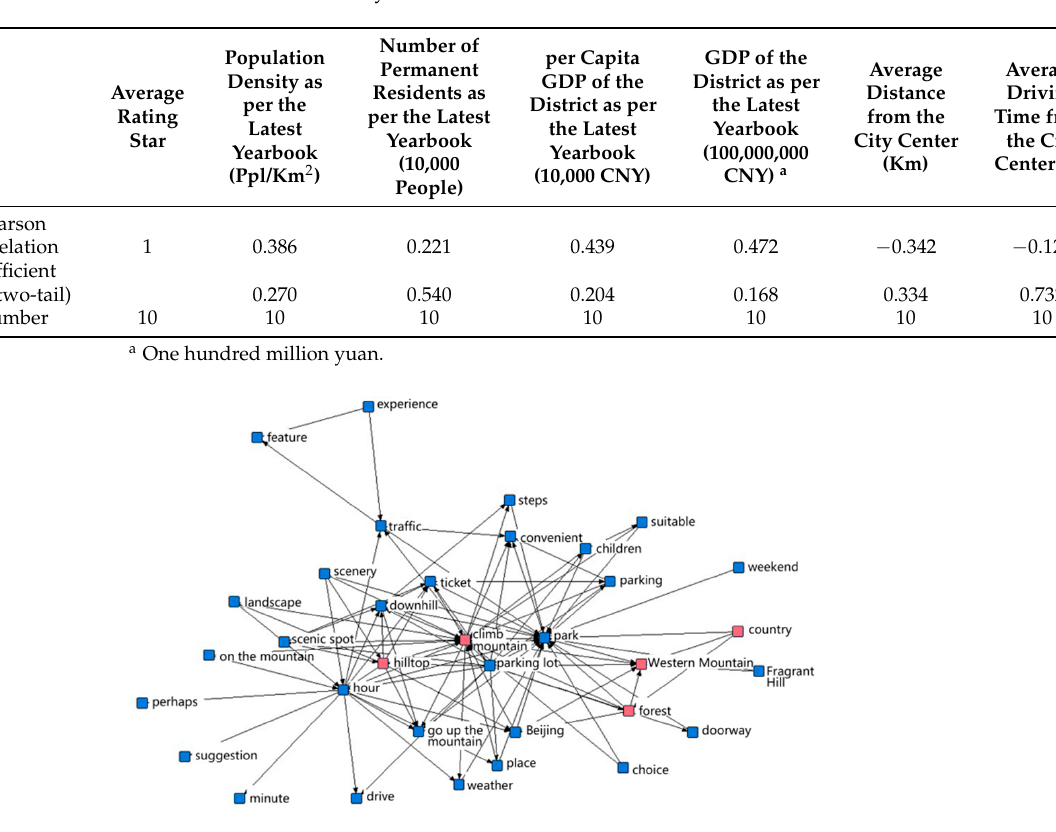
Table 8. Correlation analysis.